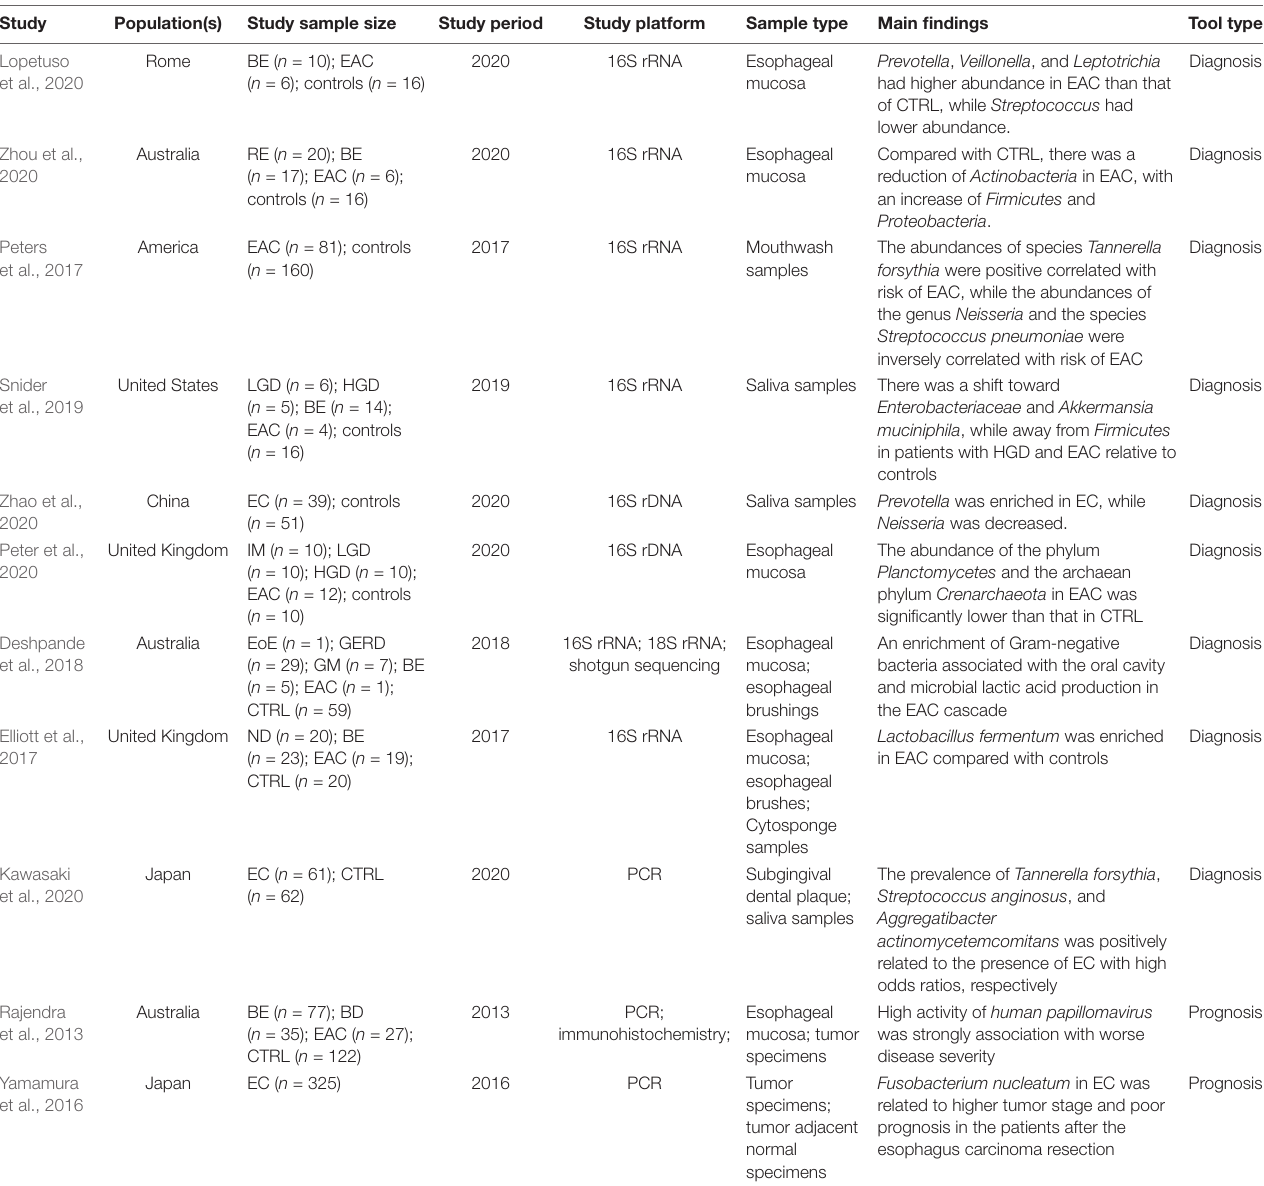
TABLE 1 | Human microbiota studies for esophageal